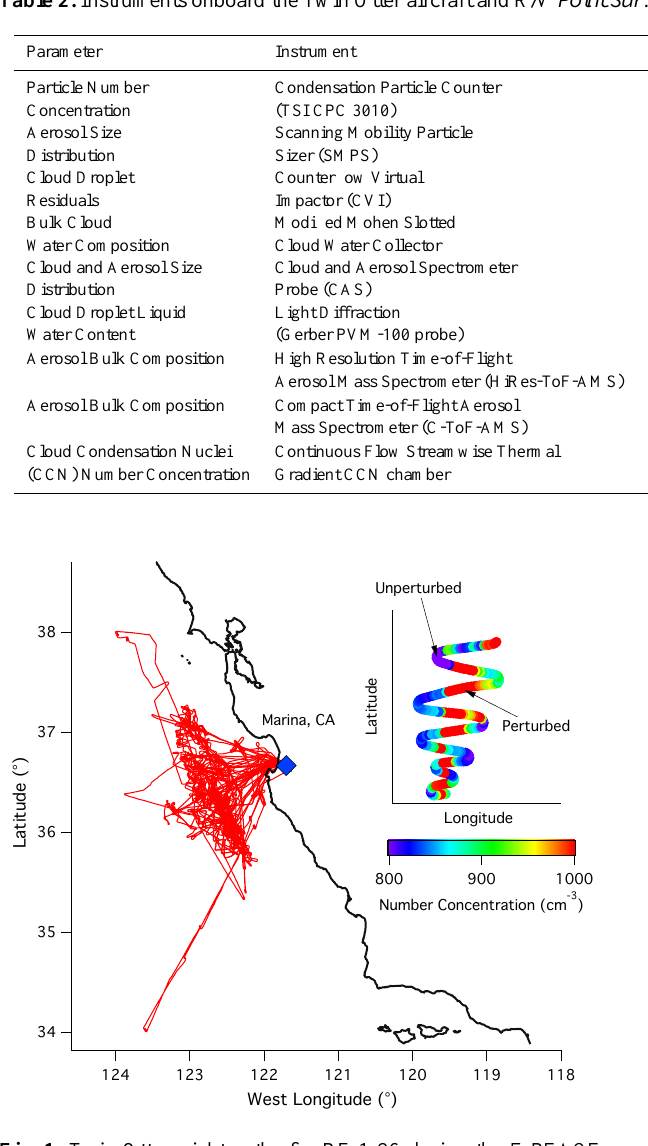
Fig. 1. Twin Otter flight paths for RF 1-26 during the E-PEACE mission. Inset shows a typical sampling pattern when encountering a ship exhaust plume. The color bar indicates the total aerosol num- ber concentration as measured by the Twin Otter